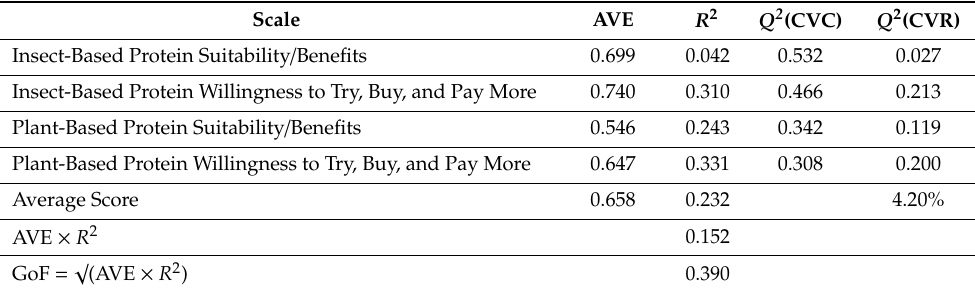
Table 4. Model Goodness of Fit (GoF)